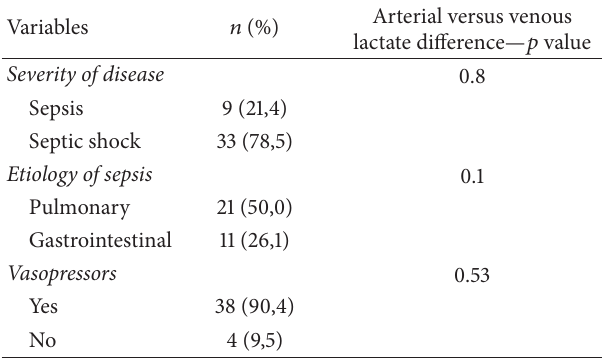
Table2:Featuresofsepsisinthepopulation.Thedifferencebetween arterial and venous lactate according to the severity of the disease, its origin, and the use of vasopressors